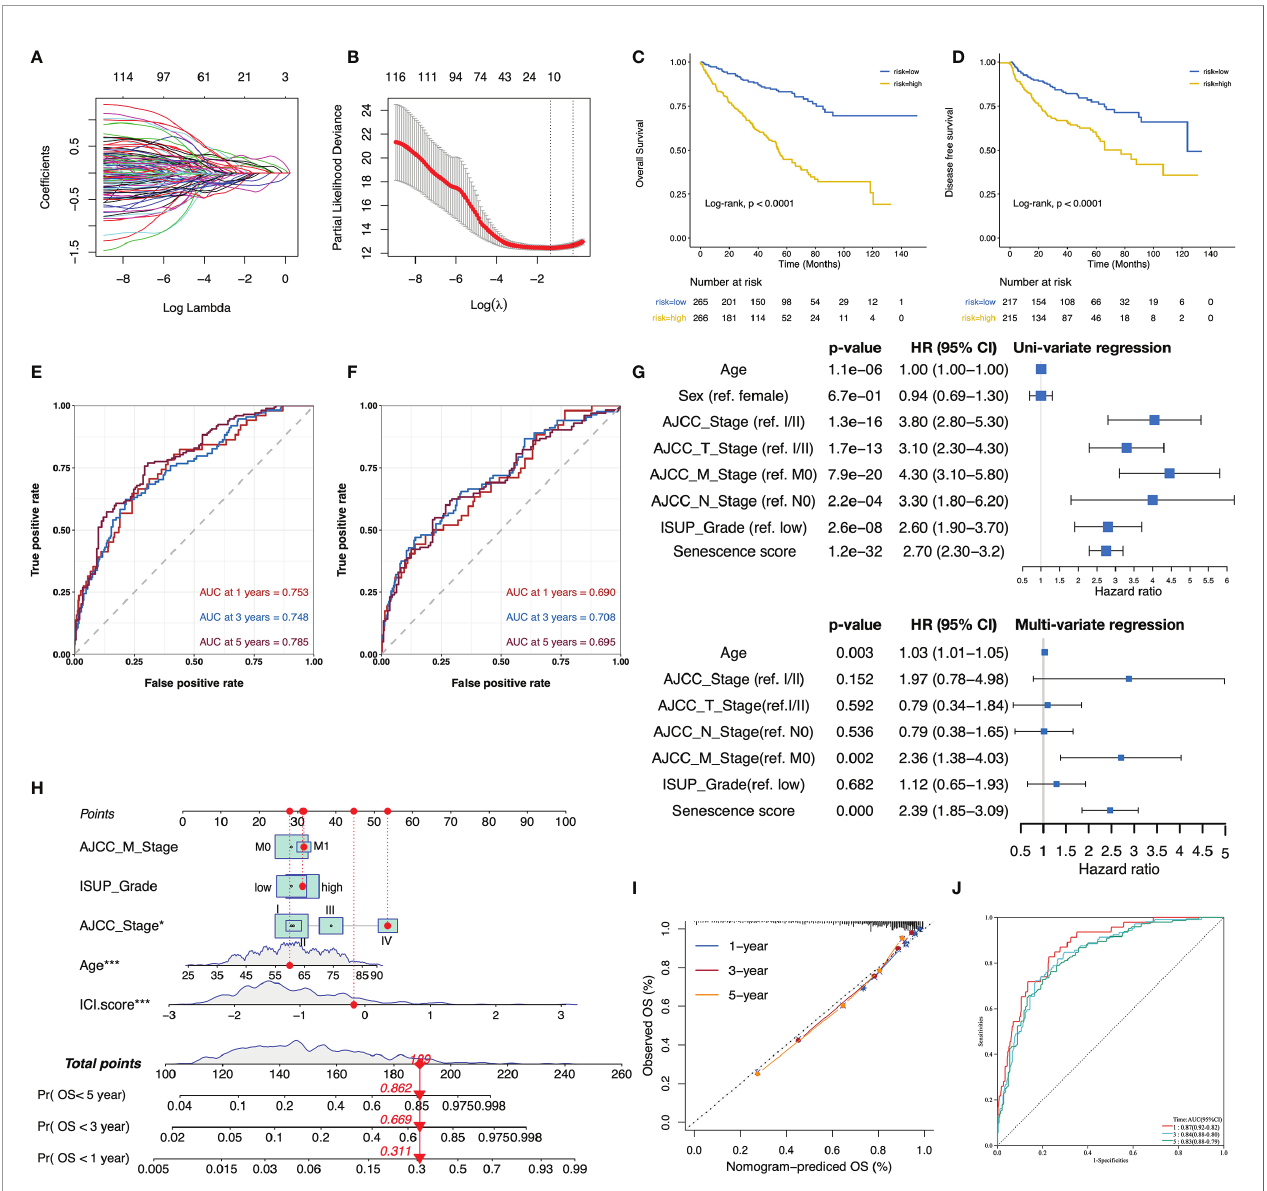
FIGURE 4 | The senescence score was a prognostic indicator for patients ’ prognosis in TCGA-KIRC. (A, B) The adaptive lasso regression selected the best combination of senescence genes to construct a multivariate Cox model. (C, D) Survival analysis showed a different survival portion between the high- and low- senescence score subgroups in TCGA-KIRC for OS (C) and DFS (D) . (E, F) The predictive power of the senescence score for 1-, 3-, and 5-year OS (E) and DFS (F) was assessed by ROC curves. (G) Forest plots of the uni- and multivariate Cox models in TCGA. (H) Nomogram to predict patients ’ overall survival. The model incorporated the AJCC_Stage, ISUP_Grade, metastatic status, patients ’ age, and the senescence score. (I) The calibration curves show that the survival status of patients predicted by nomogram at 1, 3, and 5 years remains highly consistent with that actually observed. (J) ROC curves to evaluate the predictive ef fi cacy of the nomogram for overall survival at 1, 3, and 5 years. *,p<0.05, ***,